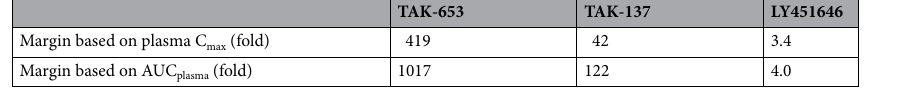
Table 2. Exposure margin against seizure after acute treatment in rats (plasma C max and AUC plasma